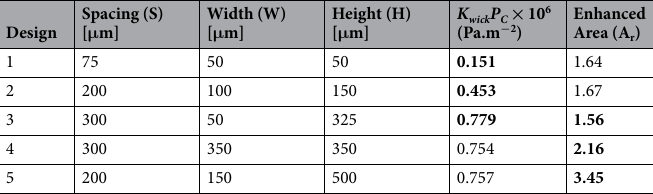
Table 1. Physical properties and wickability of surface structures.